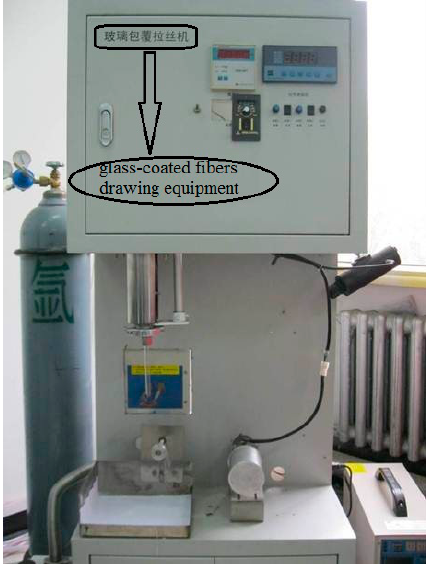
Figure 2. The picture of the glass ‐ coated fibers drawing equipment.